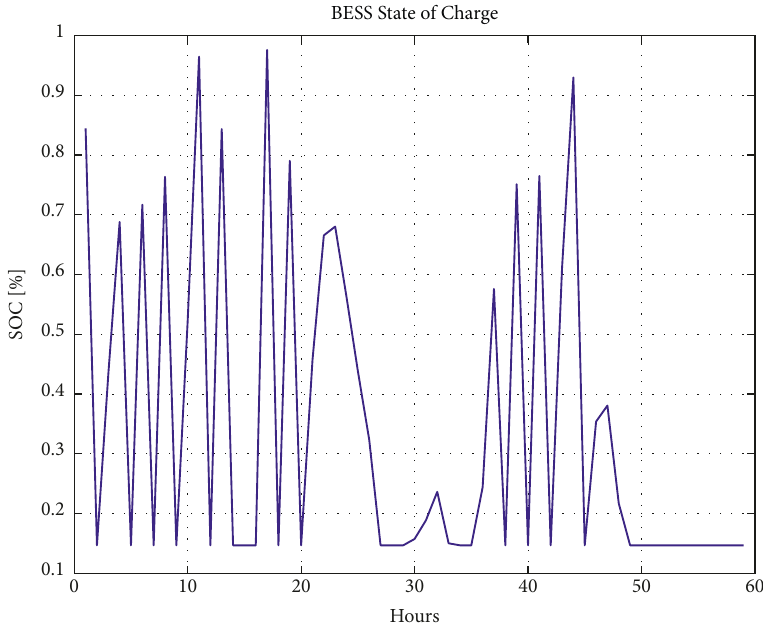
Figure 16: Variation of SOC of the BESS with time.